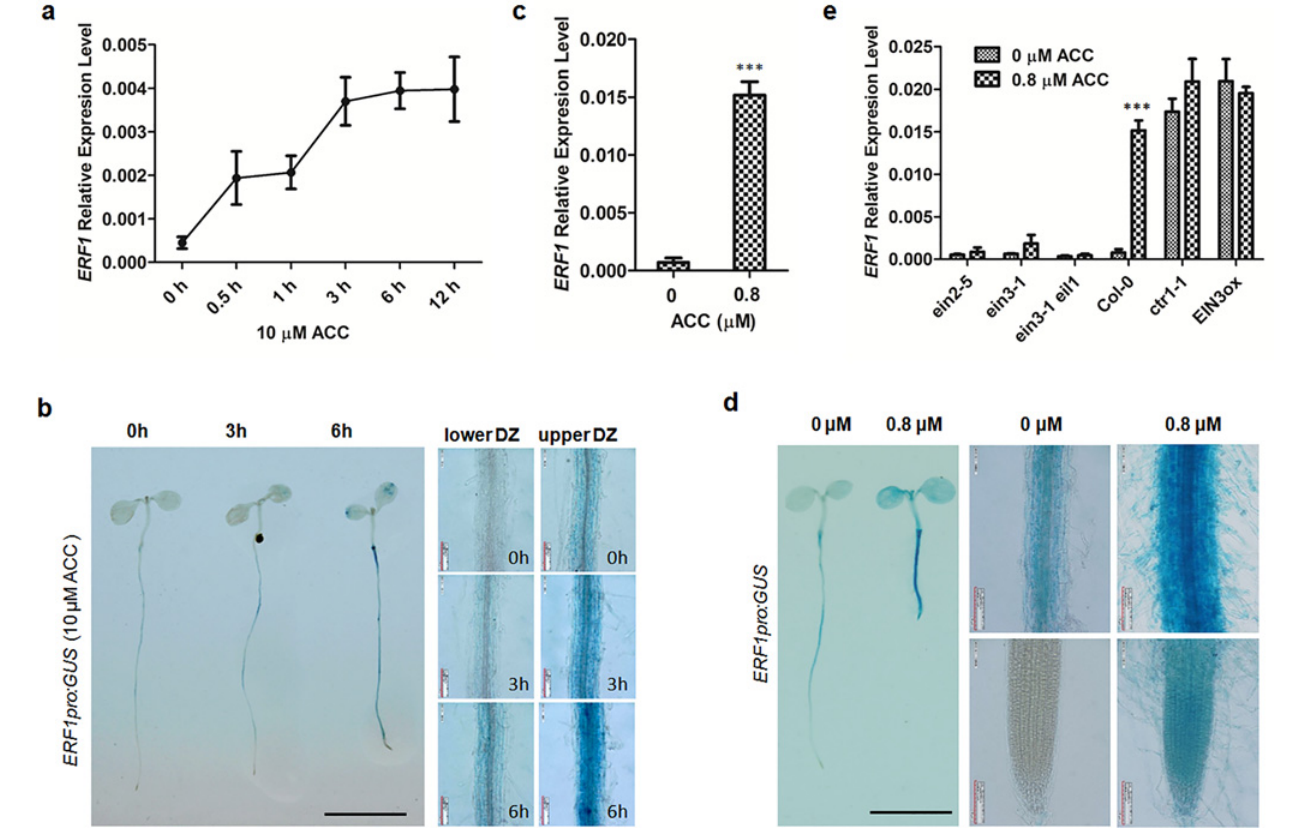
Fig 1. ERF1 expression is responsive to ethylene. ( a ) Ethylene-induced ERF1 expression in wildtype. Seeds of Col-0 were germinated on MS medium for 5 d then treated with 10 μ M ACC for 0, 0.5, 1, 3, 6, and 12 h. The transcriptional level of ERF1 was detected by quantitative RT-PCR (qRT-PCR). Values are mean ± SD of three replicates. ACC, 1-aminocyclopropane-1-carboxylic acid (precursor of ethylene biosynthesis). ( b ) Ethylene-induced expression of ERF1pro : GUS . Five-day-old seedlings of transgenic lines of were treated with 10 μ M ACC for 0, 3, and 6 h before GUS staining. Upper DZ and lower DZ represent different primary root regions. Scale bar, 0.5 cm. ( c ) Ethylene-induced expression of ERF1 in wildtype. Seeds of Col-0 were germinated on MS medium with 0 or 0.8 μ M ACC for 5 d, and relative ERF1 transcription levels measured by qRT-PCR. Values are mean ± SD of three replicates ( *** P < 0.001). Asterisks indicate Student ’ s t-test significant differences. ( d ) Ethylene-activated expression in ERF1 pro : GUS lines. Transgenic plants were grown MS medium with either 0 or 0.8 μ M ACC for 5 d before GUS staining assay. Scale bar, 0.5 cm. ( e ) The relative ERF1 expression level was determined in ethylene signaling related mutants ein2-5 , ein3-1 , ein3-1eil1 and compared to wildtype (Col-0) seedlings. Seedlings carrying constructs for either constitutive ( ctr1-1 ) or inducible EIN3-FLAG ( iE / qm ) ( EIN3ox ) expression were also examined. Seedlings were geminated on MS medium with either 0 or 0.8 μ M ACC for 5 d. Seeds of EIN3ox were grown on medium containing 1 μ M β -estradiol and 0 or 0.8 μ M ACC. Roots of seedlings were used for qRT-PCR analysis. Values are mean ± SD of three replicas ( *** P < 0.001). Asterisks indicate Student ’ s t-test significant